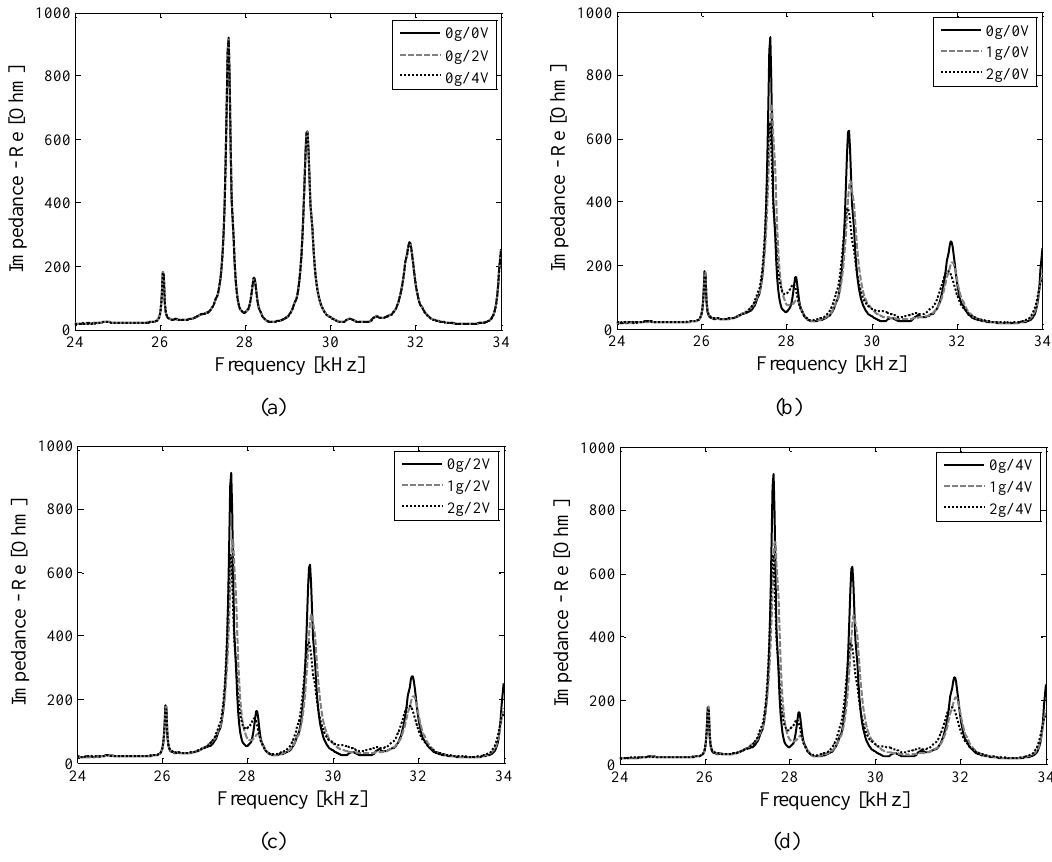
Fig. 6. Impedance Measurement: (a) varying the electromagnetic field (0 V, 2 V and 4 V); (b) varying the added mass to the structure for constant electromagnetic field (0 V); (c) varying the added mass to the structure for constant electromagnetic field (2 V); (d) varying the added mass to the structure for constant electromagnetic field (4 V).